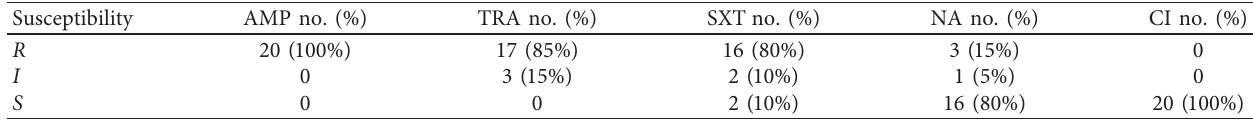
Table 4: Drug resistance/susceptibility pattern of Salmonella species isolated in thepresent study ( n � 20). Susceptibility